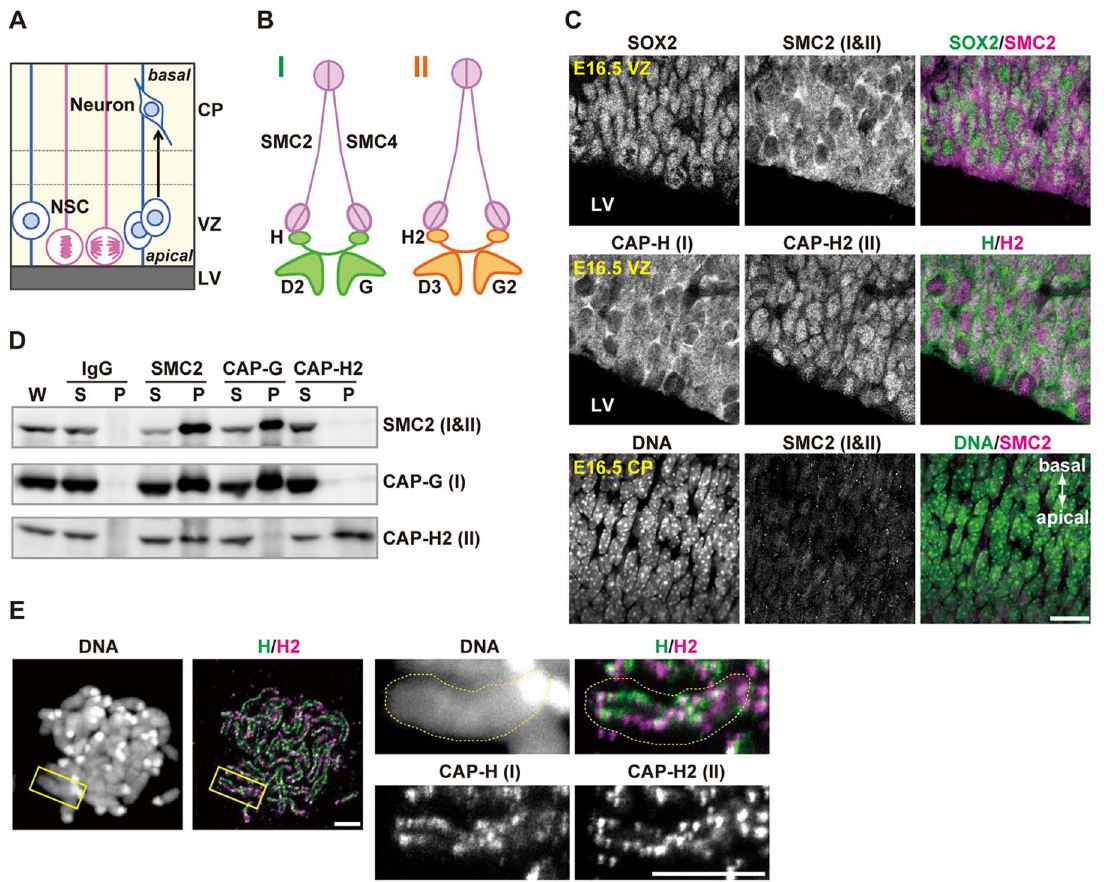
Figure 1. Condensins I and II are both present in NSCs. ( A ) Schematic representation of NSC division and neural differentiation. NSCs possess radial fibers along apico-basal polarity and exhibit cell cycle-dependent nuclear movement (i.e., interkinetic nuclear migration). LV, VZ and CP indicate the lateral ventricle, the ventricular zone and the cortical plate, respectively. ( B ) Subunit composition of the condensin complexes. Both complexes share the same pair of SMC core subunits (SMC2 and SMC4). Condensin I possesses three non-SMC subunits (CAP-D2, CAP-G and CAP-H) whereas condensin II has a distinct set of non-SMC subunits (CAP-D3, CAP-G2 and CAP-H2). ( C ) Frozen sections of embryonic brains were immunolabeled with antibodies against SOX2 (an NSC marker) and condensin subunits. Areas containing the VZ were labeled with antibodies against SOX2 and SMC2 (upper panels) or against CAP-H and CAP-H2 (middle panels). An area containing the CP was labeled with an SMC2 antibody. DNA was counterstained with Hoechst (lower panes). The data shown are from a single representative experiment out of three repeats. Sections from three different embryos were used. Bar, 20 m m. ( D ) Brain extracts prepared from C57BL/6J embryos at E12.5 are subjected to immunoprecipitation assay with antibodies against condensin subunits and control IgG as indicated on the top. The precipitates (P) along with whole cell extracts (W; 5% of input) and non-precipitated supernatants (S; 5% of input) were analyzed by western blotting. ( E ) Metaphase spreads were prepared from NSC cultures and immunolabeled with specific antibodies against CAP-H and CAP-H2. DNA was counterstained with Hoechst. Maximum intensity projections are shown. The right four panels indicate close-up views of a representative chromosome (indicated by the yellow rectangles in the left panels). The perimeter of the chromosome is indicated by the dotted lines. The data shown are from a single representative experiment out of two repeats. Bars, 5 m m.